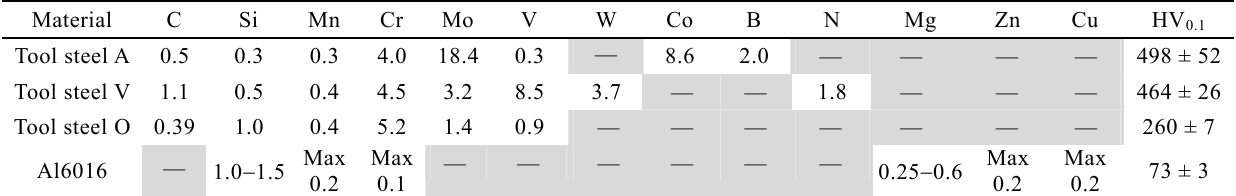
Table 1 Chemical composition (wt%, as provided by the supplier) and measured microhardness of the investigated materials (Fe for the steels and Al for the aluminium make up the balance).